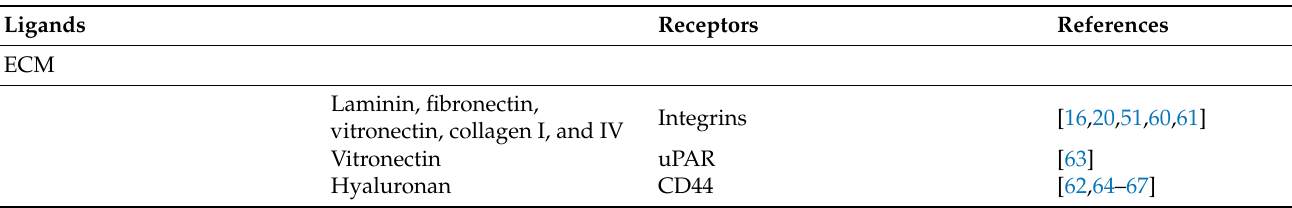
Table 2. Adhesion